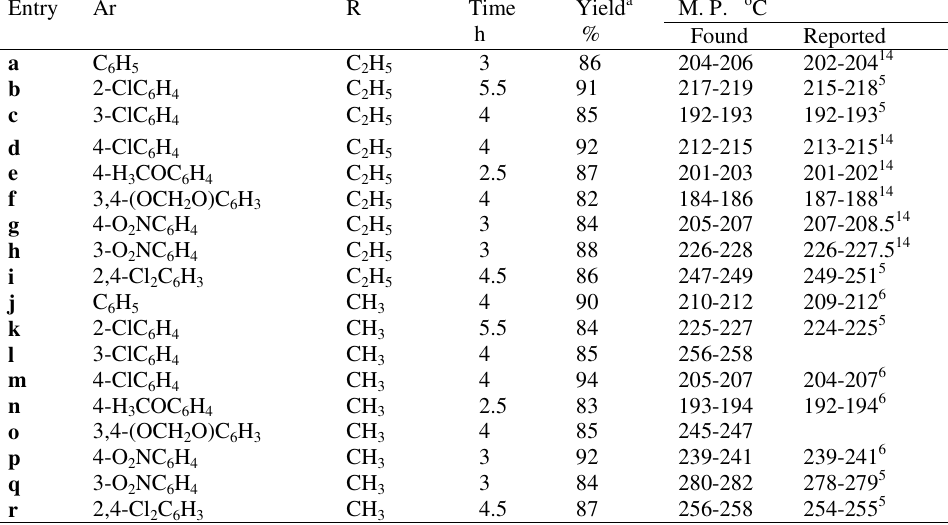
Table 1 Synthesis of 3,4-dihydropyrimidin-2(1H)-ones using ClSO 3 H as